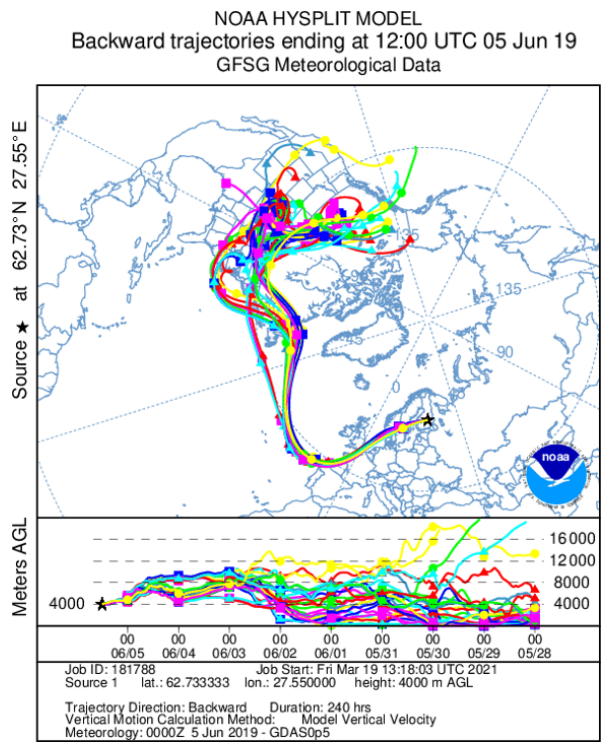
Figure 4. Ten-day backward trajectories from the HYSPLIT model (in ensemble type), ending at 12:00UTC on 5 June 2019 for Kuo- pio, Finland. The end location of the air mass is at 4kma.g.l. in the SPoI (smoke plume of